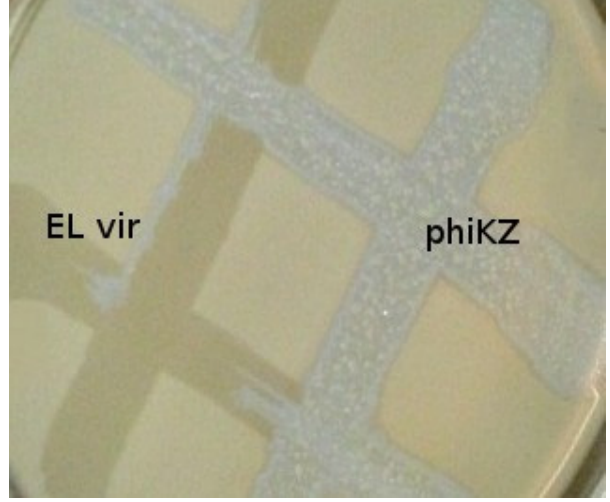
Figure 2. Phylogenetically related bacteriophages phiKZ and EL have repressors of different specificity. Virulent mutant ELvir5 cannot lyse phiKZ wild type infected pseudolysogenic cells (plated on a lawn of bacteria P. aeruginosa